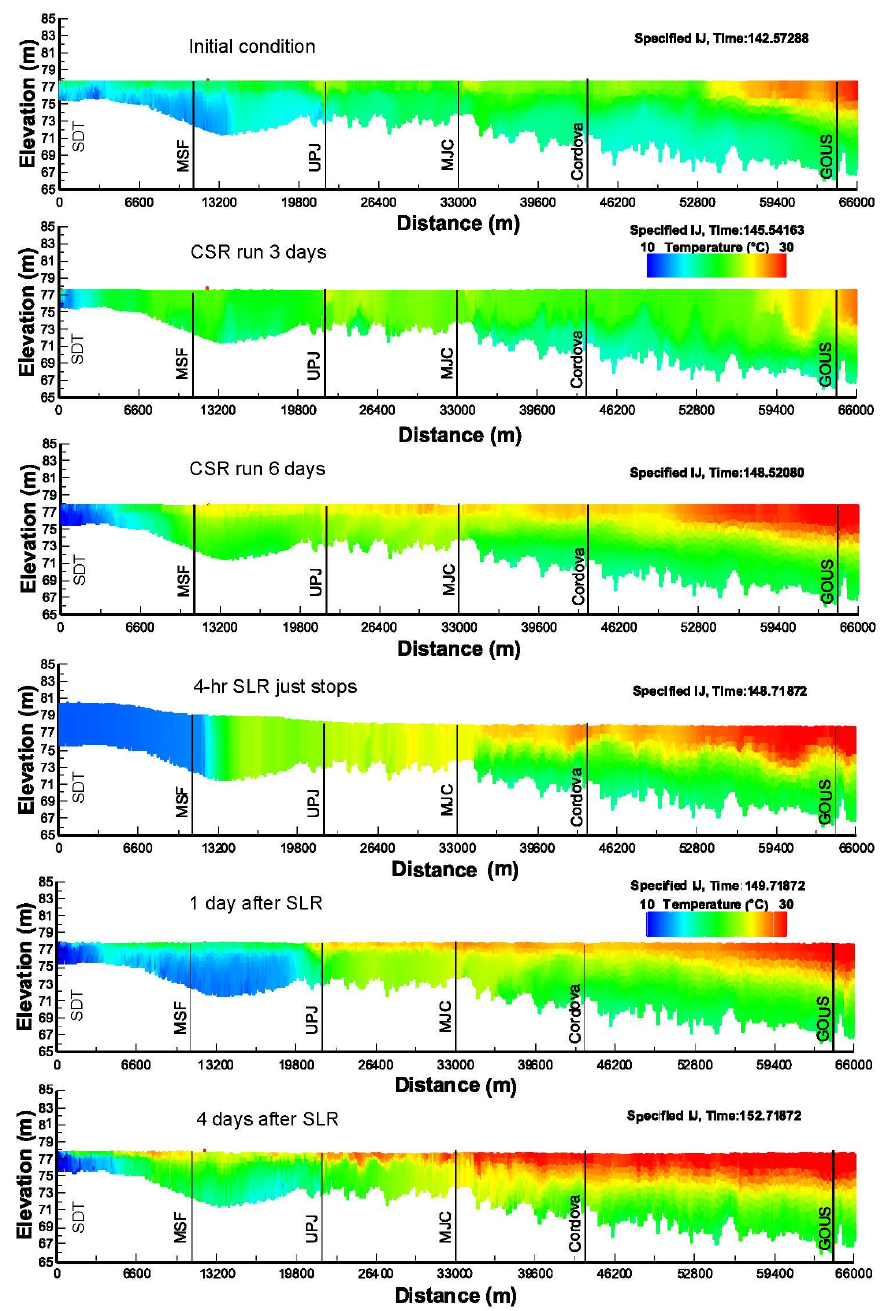
Figure 5. Simulated water temperature distributions from SDT to GOUS at six different times for the 4-h SLR simulation: at the beginning of the model run (initial conditions), after about three and six days with CSR, when the 4-h SLR stops (on the seventh day), and about one and four days after